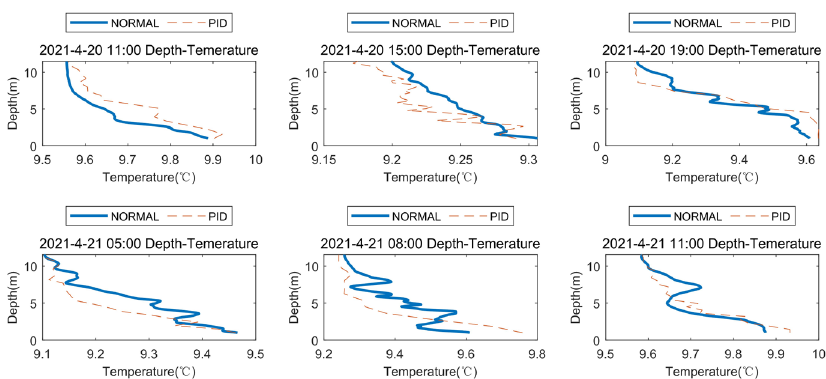
Figure 19. Experimental results of the offshore survey.